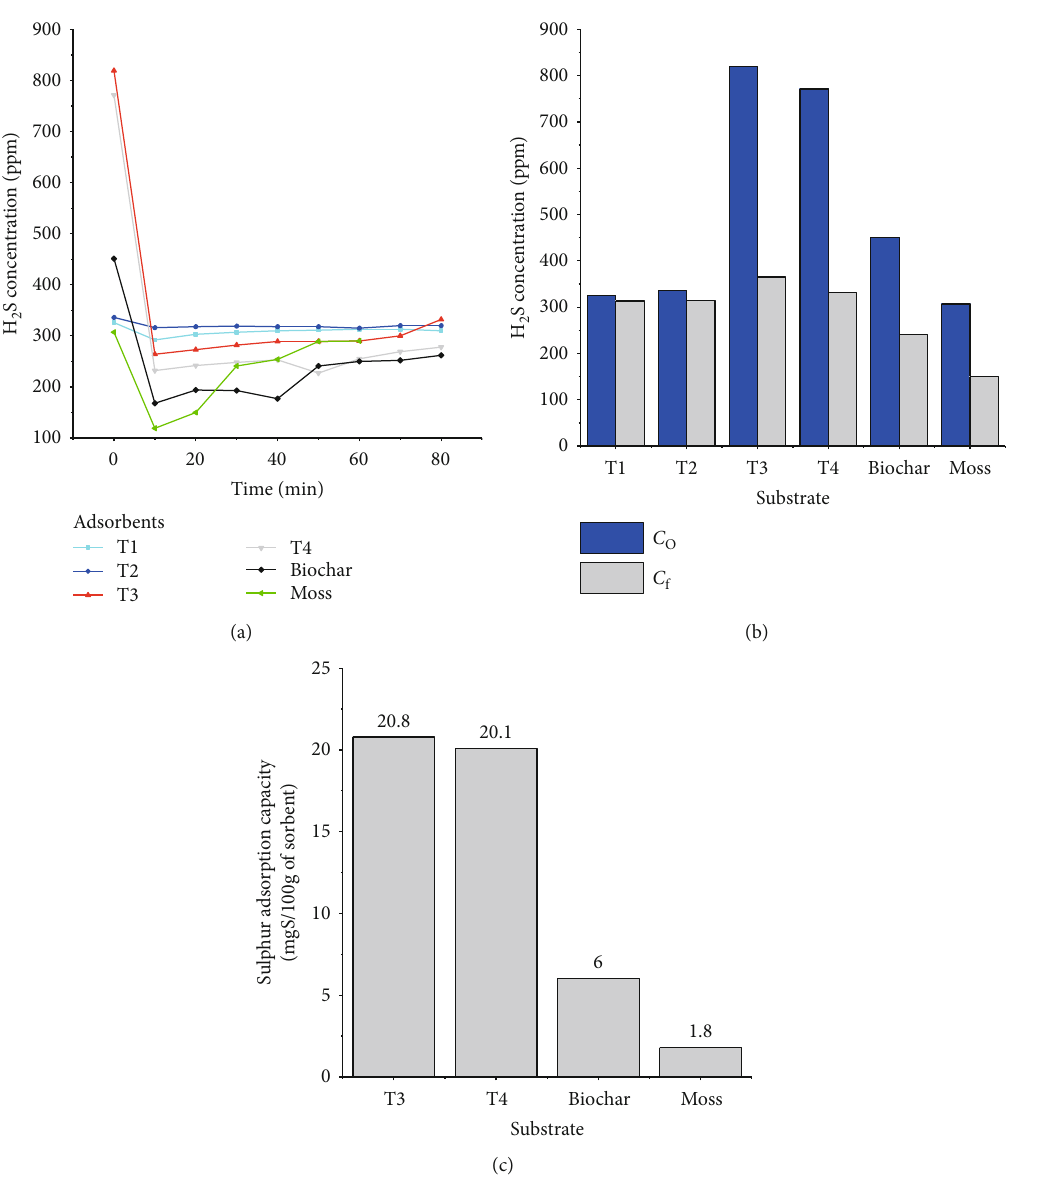
Figure 7: Sulfur removal by various adsorbents: (a) breakthrough curves, (b) H capacities. Test conditions: Q = 100 ml/min, m = 5 g, C 0 = 307 -819ppm for H